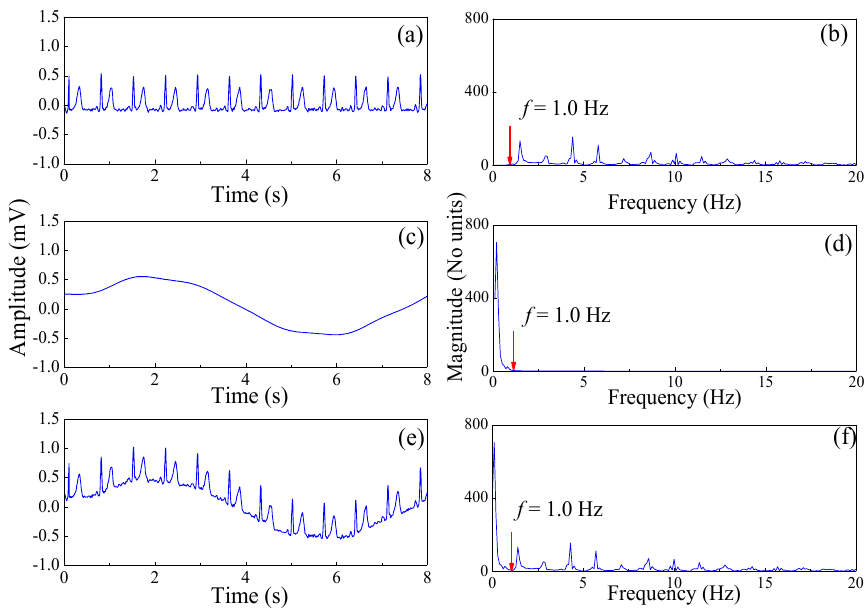
Figure 3. ( a ) The time domain diagram of the clean ECG. ( b ) The frequency domain diagram of the clean ECG. ( c ) The time domain diagram of the motion artifact noise. ( d ) The frequency domain diagram of the motion artifact noise. ( e ) The time domain diagram of the noisy ECG signal. ( f ) The frequency domain diagram of the noisy ECG signal.